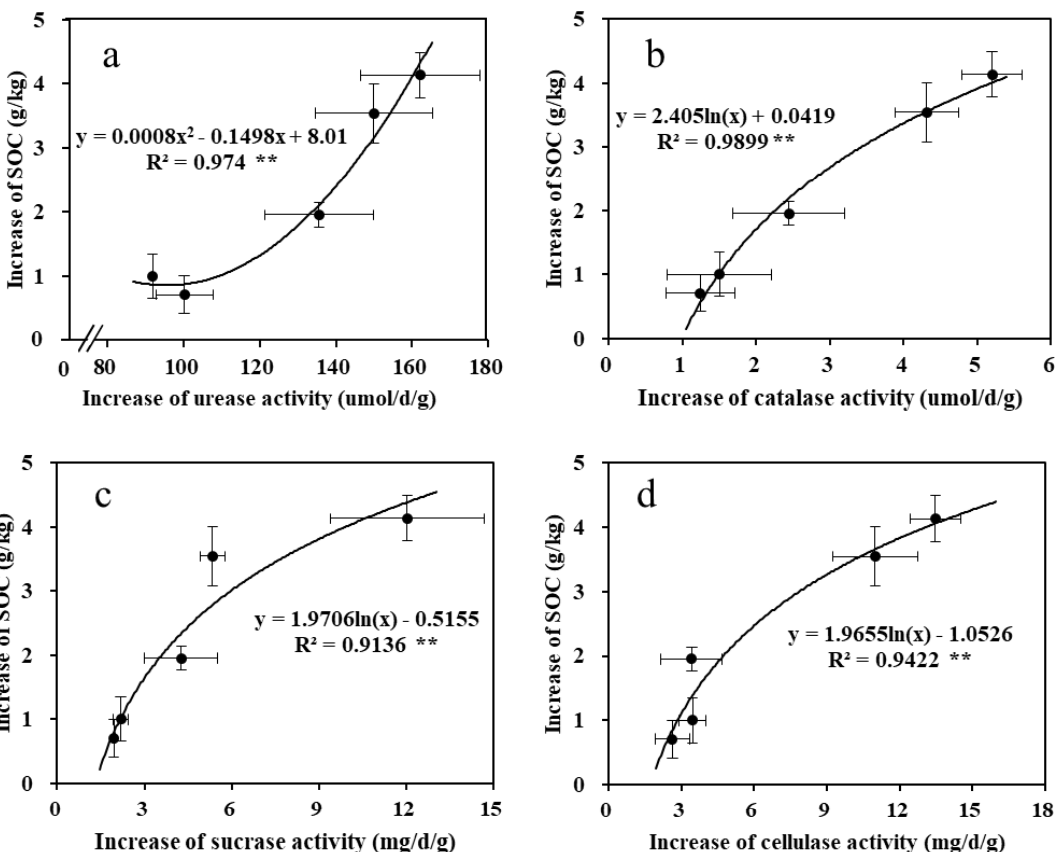
Figure 3. Linear regression analysis between increases in SOC and urease ( a ), catalase ( b ), sucrase ( c ), and cellulase ( d ) activities. Values on the horizontal axis denote increases in urease, catalase, sucrase, and cellulase activities, respectively, whereas those on the vertical axis denote the increase in SOC vs. CK. ** p < 0.05.